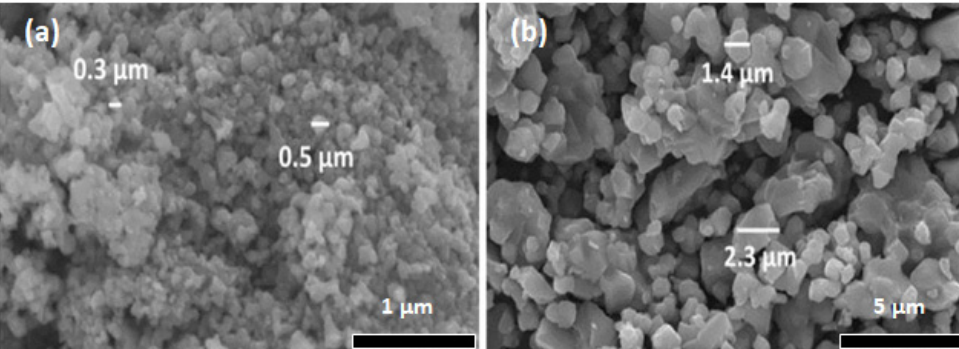
Figure 3. SEM micrographs for CuFe 2 O 4 obtained by different methods: ( a ) Sol-Gel method and ( b ) hydrothermal synthesis. The images show the effect of methods of synthesis for the materials obtained [68]. Republished with permission from Elsevier.